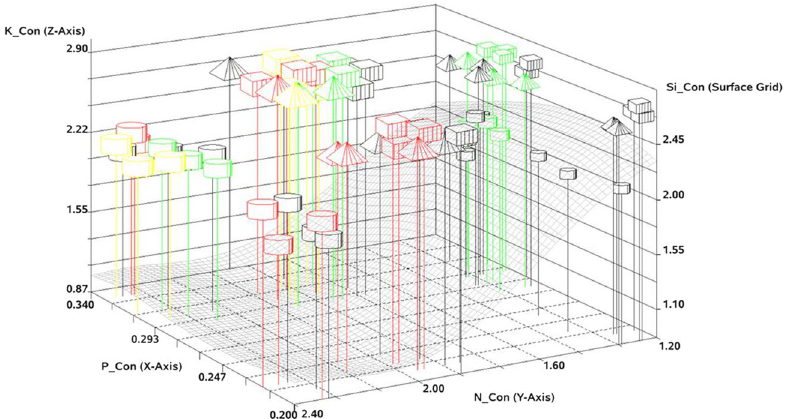
Figure 7. Relationship among measured rice plant attributes and brown planthopper (BPH) fitness traits for intrinsic rate of increase ( r m